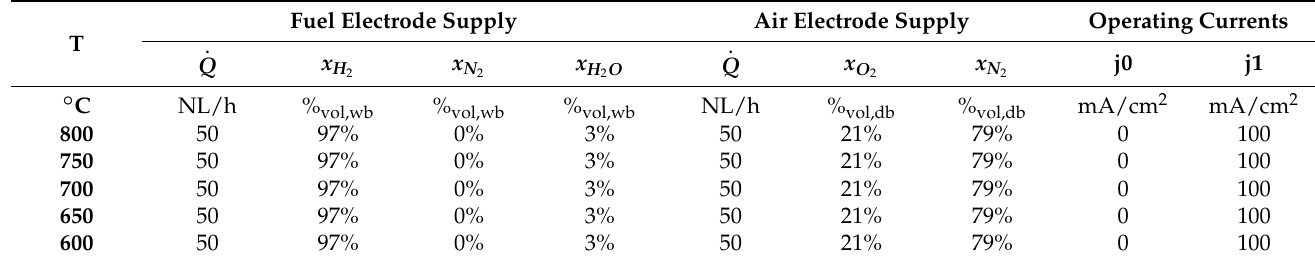
Table 3. Design of experiments—part 2 “temperature